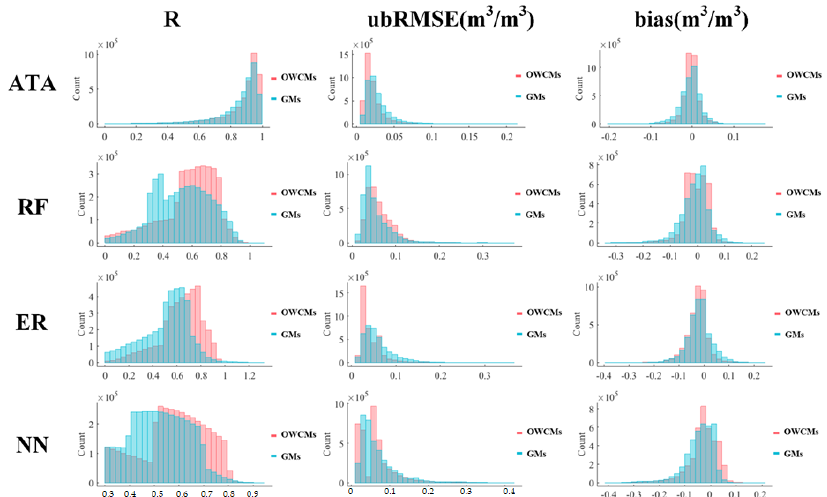
Figure 7. Frequency distributions of the statistical metrics R (1st column), ubRMSE (2nd column), and bias (3rd column) between the ATA (1st row)/RF (2nd row)/ER (3rd row)/NN (4th row)-based OWCM/GM SM and the original RFSM over the